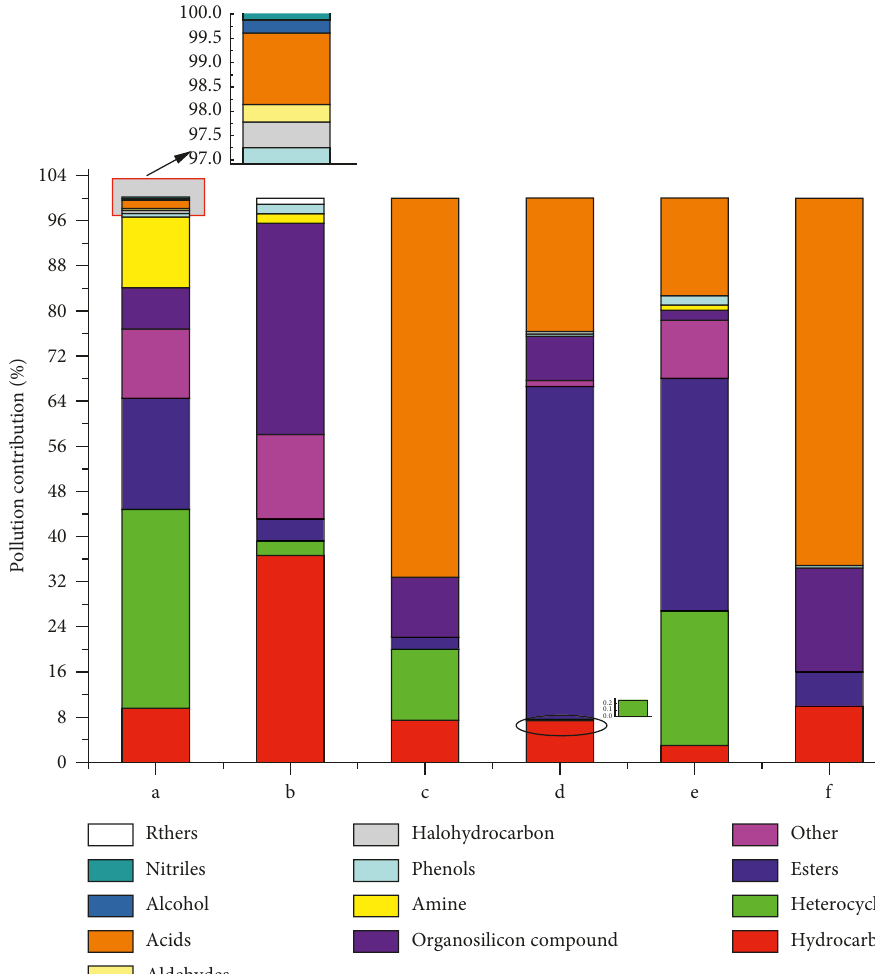
Figure 4: Distributions of the pollution contribution of the classes of refractory organic compounds in three types of typical pharmaceutical wastewater: (a), (c), and (e) represent the influent of antibiotic wastewater, Chinese traditional medicine wastewater, and chemical synthesis wastewater, respectively; (b), (d), and (f) represent the corresponding